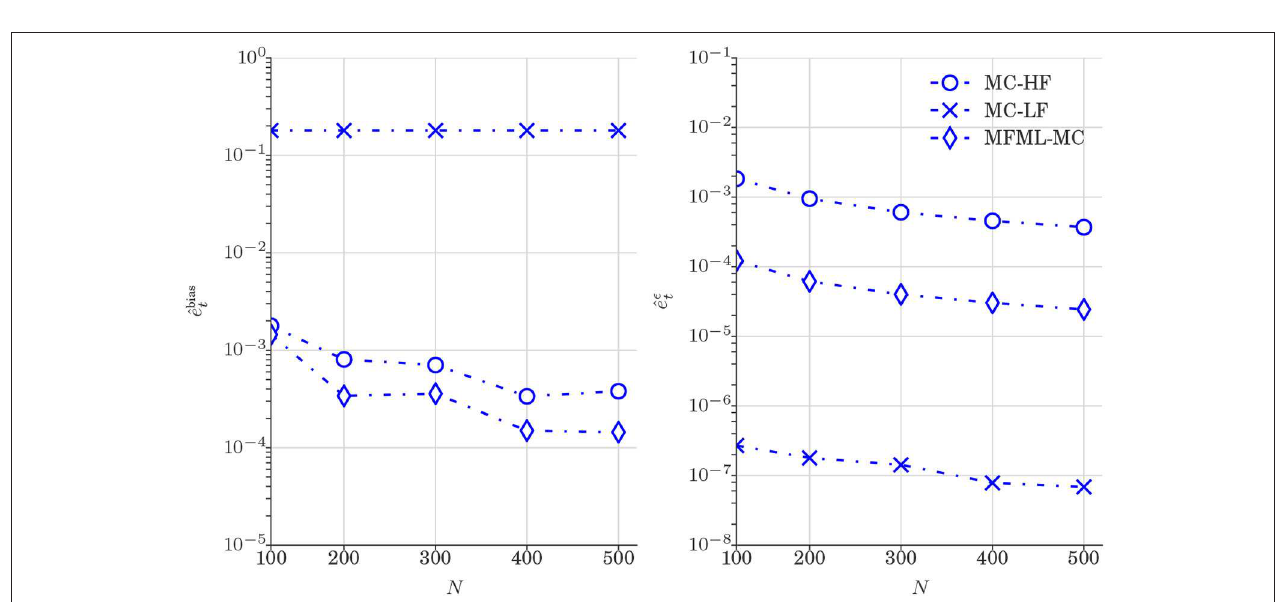
6 spatial grid) for a fixed computational budget p × 0.3 PVI. (Bottom Row) Estimation of E [ u t ] at time t =